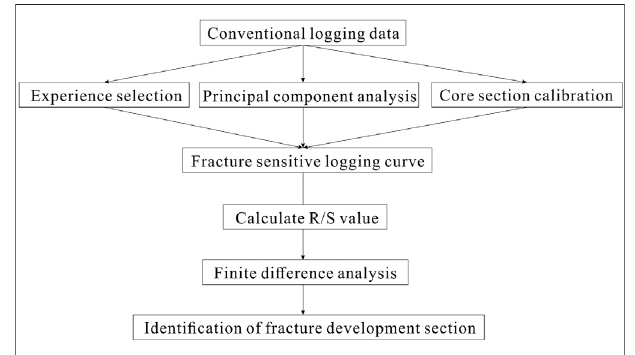
FIGURE 5 | Process of identifying fracture development section based on R/S-FD method.